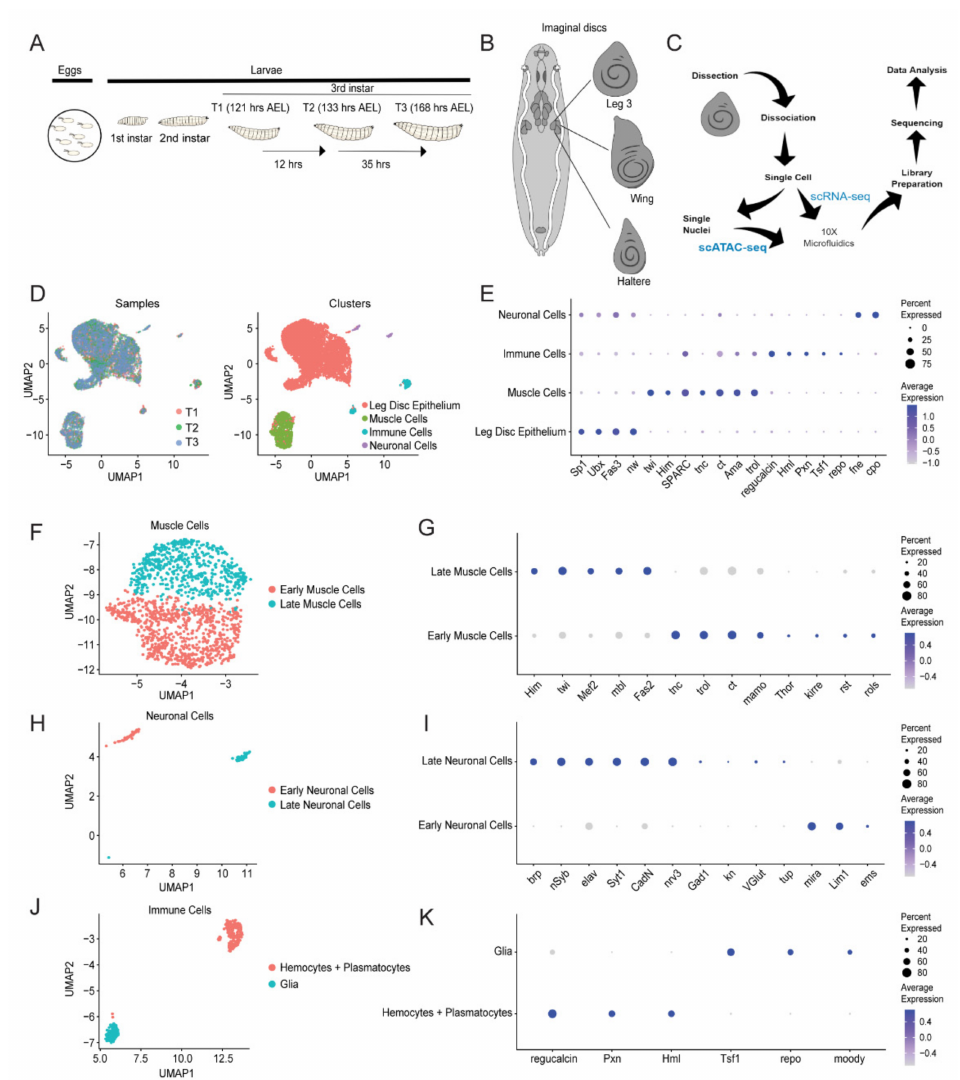
Figure 1. scRNA-seq revealed the major cell types of D. melanogaster third-instar third leg discs. ( A ) The time course of leg disc dissection. Embryos grew until dissection at T1 (121 h AEL), T2 (133 h AEL) or T3 (168 h AEL). ( B ) The third leg disc was differentiated from other leg discs as it occurred as a mid-size disc with a concentric ring-like pattern at its center within a trio of discs on bilateral sides of the larvae which also included the wing and haltere discs. ( C ) Flowchart of scRNA-seq